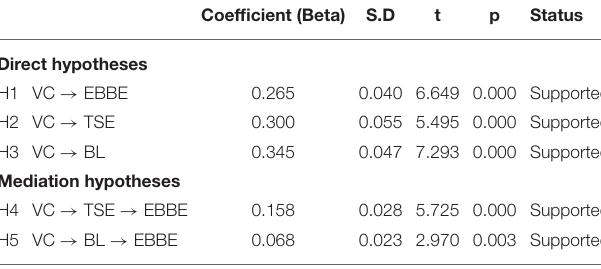
TABLE 5 | Hypotheses